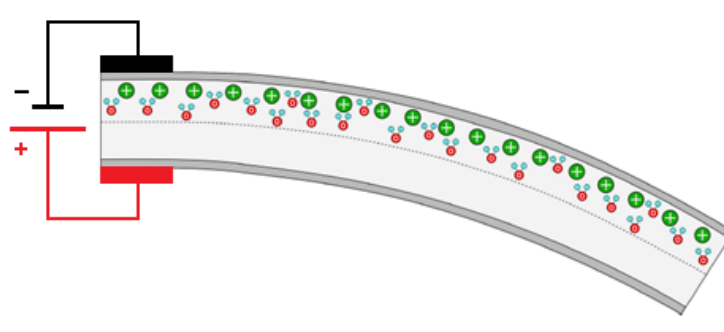
Figure 2. Reaction of IPMC Polymer to an applied